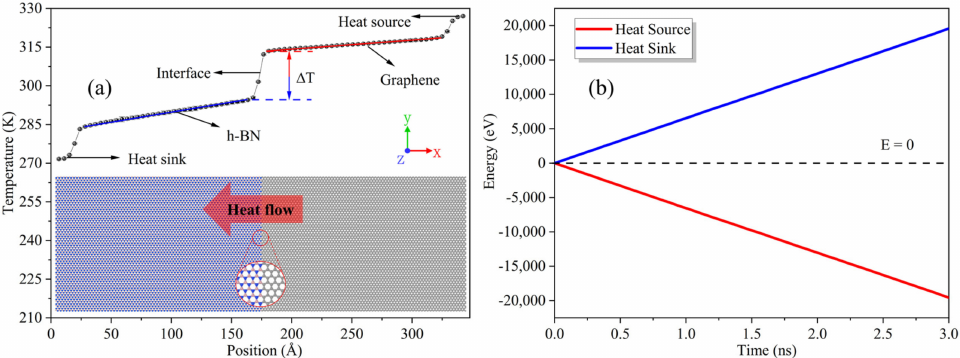
Figure 1. ( a ) At a system temperature of 300 K, the typical steady-state temperature profile of the pristine graphene/h-BN in-plane heterostructure was calculated using the NEMD method. ( b ) Using a Langevin thermostat, the cumulative energy of the heat source located in the graphene domain and the heat sink of the h-BN domain varied with simulation